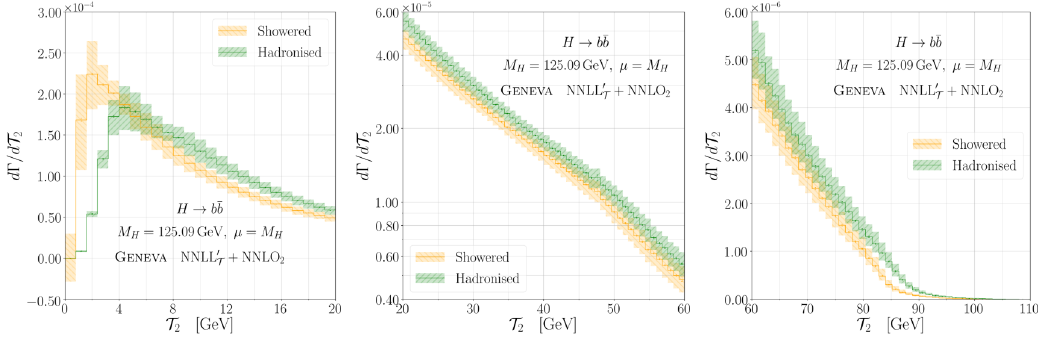
Figure 6. Comparison of the showered and hadronised T 2 spectra in Geneva for H ! b (cid:22) b